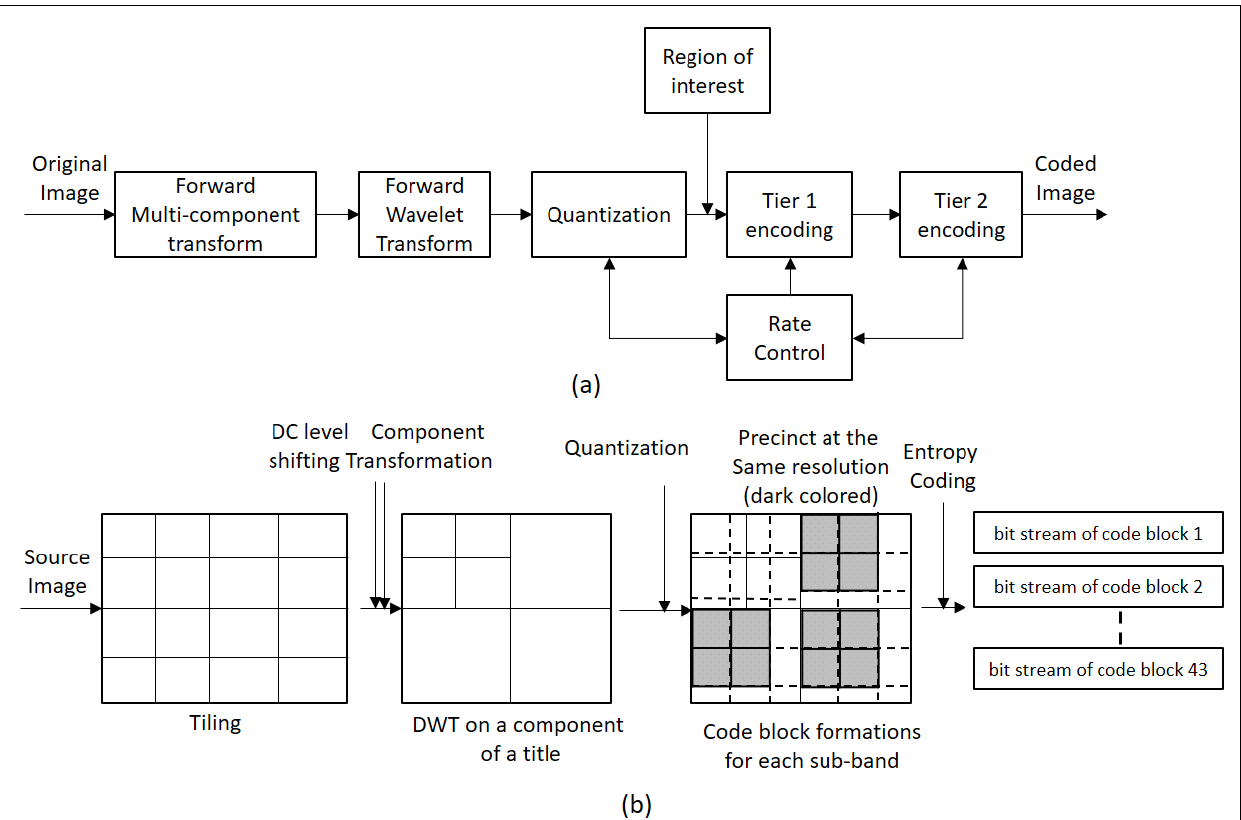
Figure 10. ( a ) JPEG 2000 encoder; ( b ) dataflow